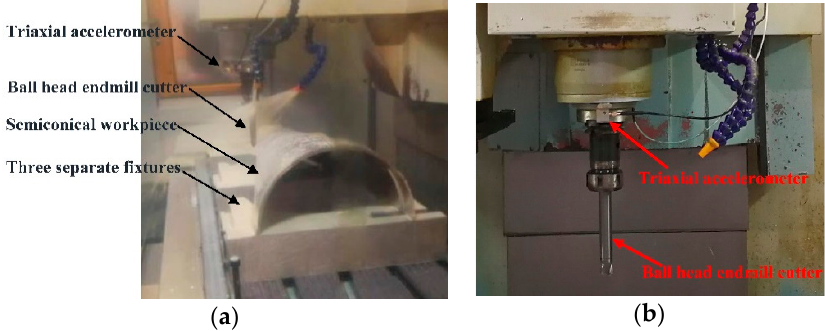
Figure 14. Photos of experimental setup ( a ) milling experiment; ( b ) ball head endmill cutter and accelerometer.